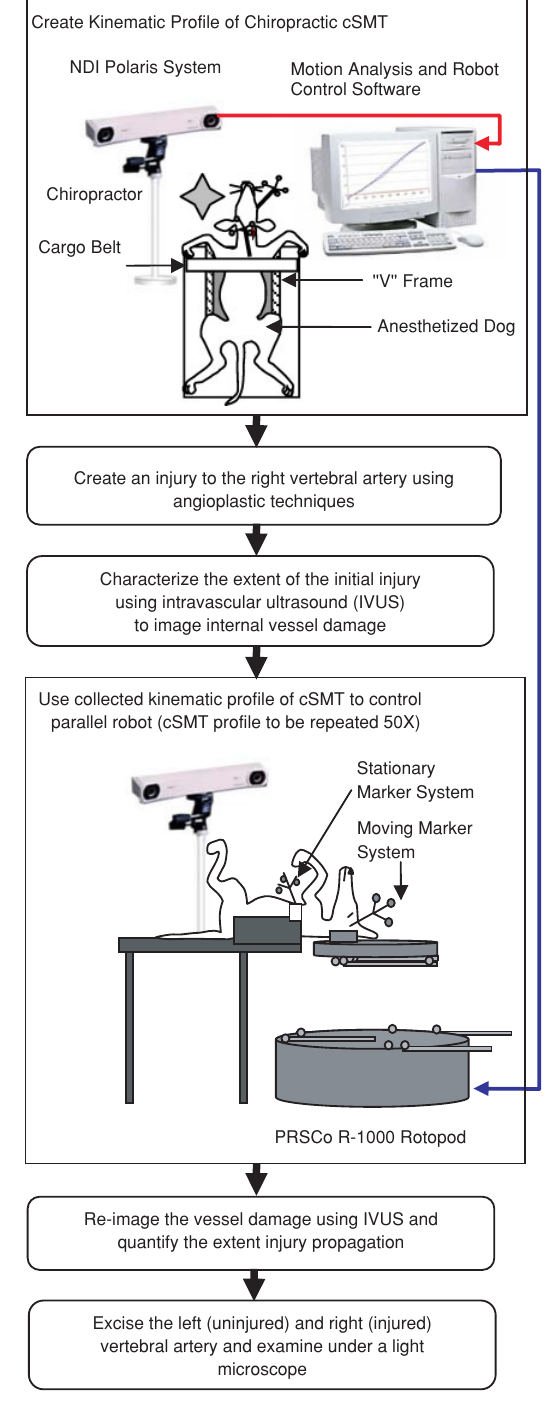
Figure 1 Schematic representation of the overall experimental protocol for chiropractic manipulation